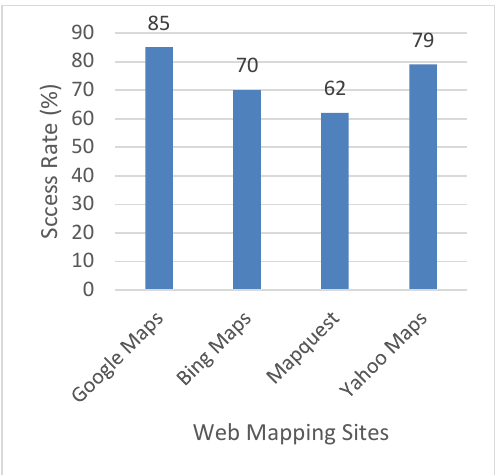
Figure 2 Success Rate (%) for four web mapping